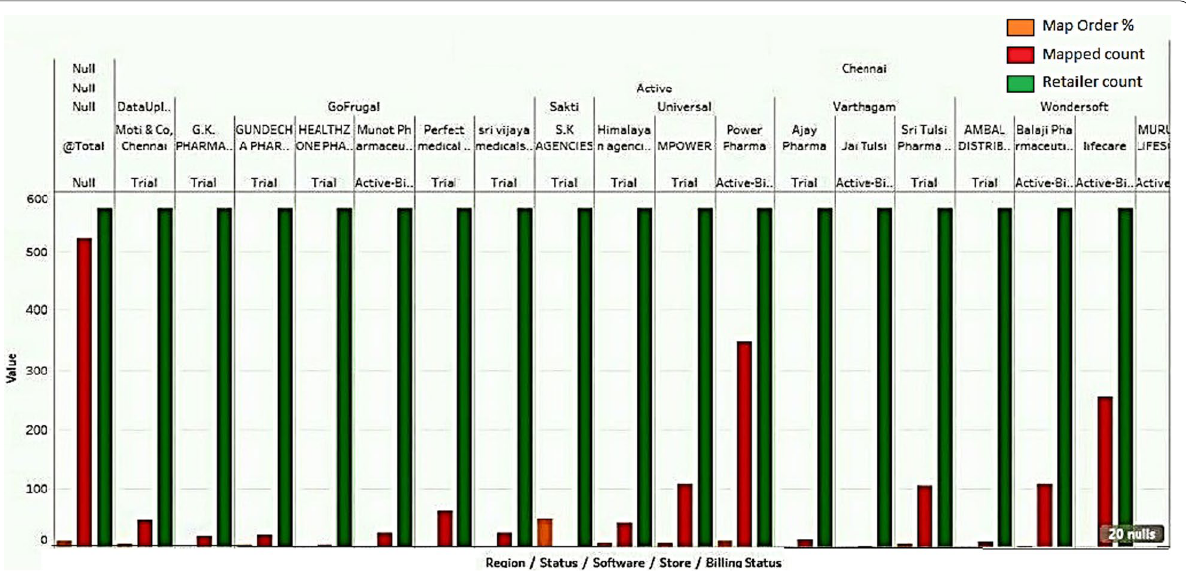
Fig. 7 Analytical view of physical server worksheet functions using